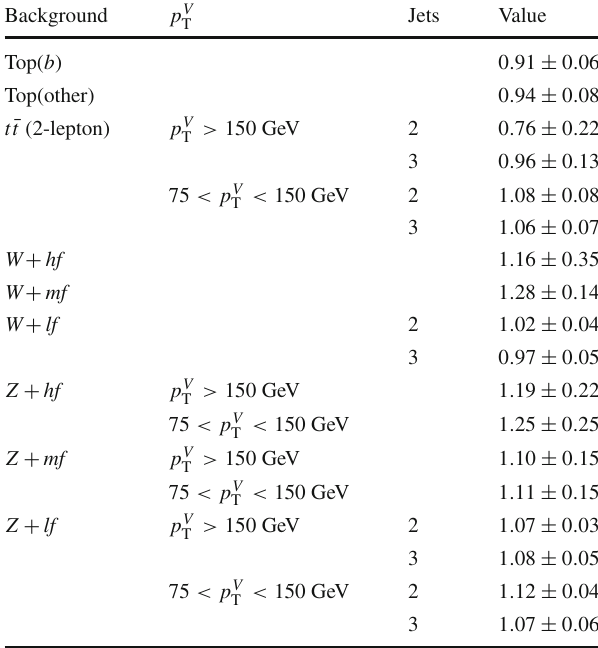
Table 4 Values of the free-floating background normalisation param- eters obtained from the likelihood fit to data. The uncertainties repre- sent the combined statistical and systematic uncertainties. Unless other- wise stated, normalisation parameters are correlated across all p V number-of-jets analysis regions